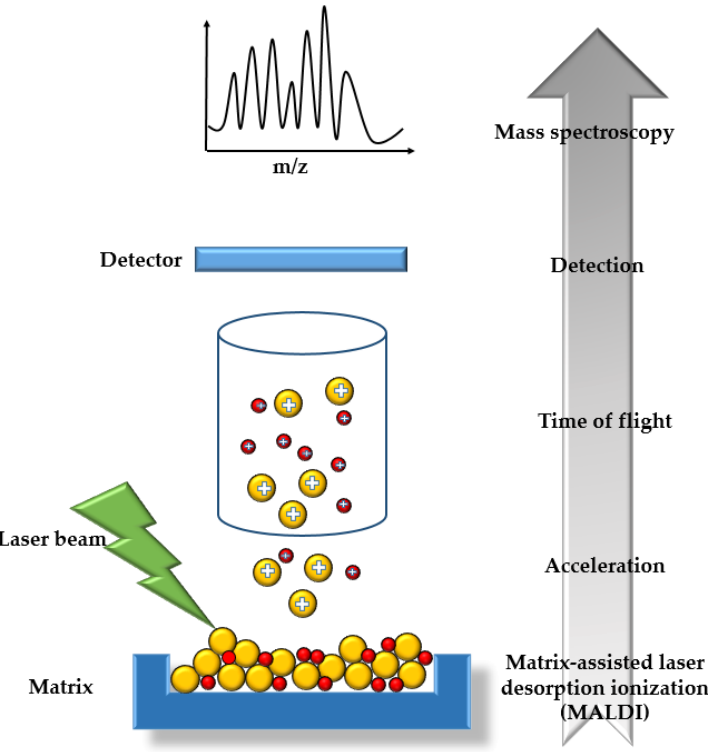
Figure 7. MALDI-TOF-MS measurement mechanism